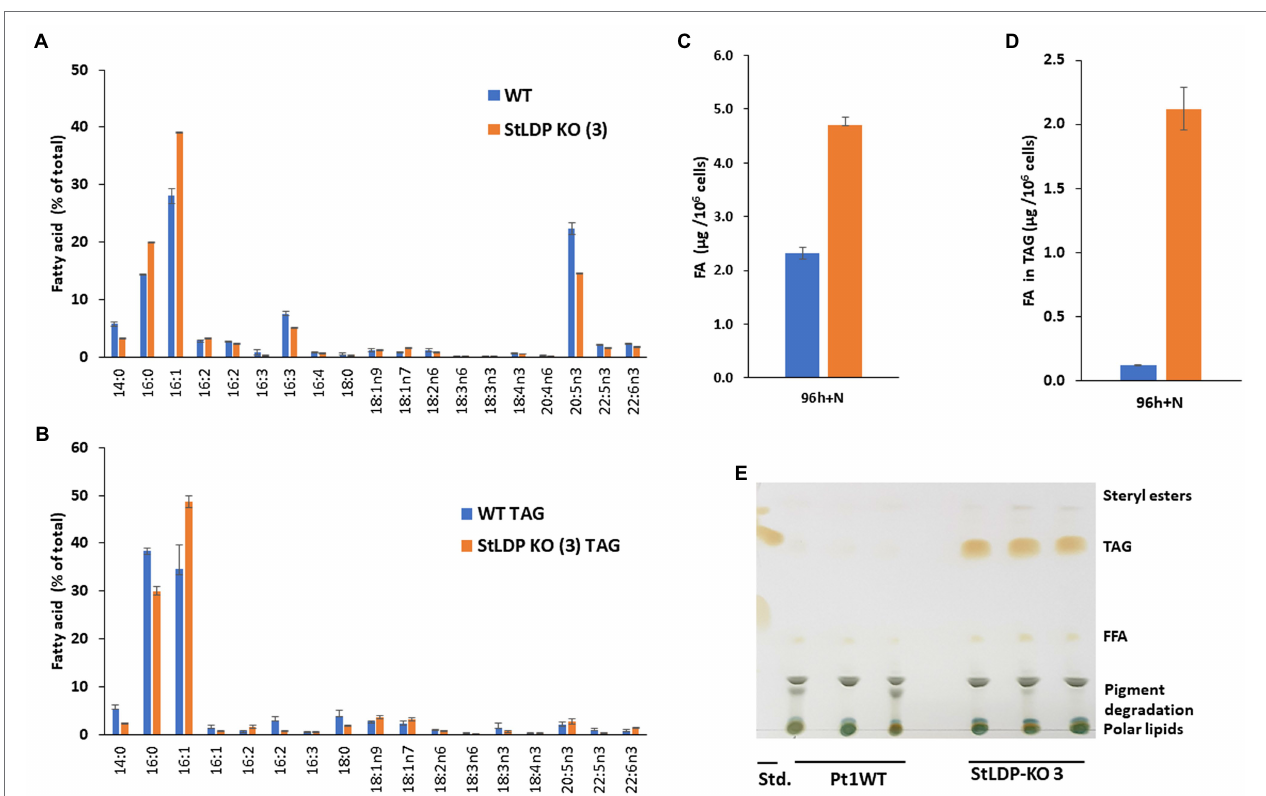
FIGURE 5 | Fatty acid analysis of wild-type Pt1 and StLDP -KO (3) under nutrient-replete conditions by gas chromatography (GC). (A) Relative abundance of total fatty acids (%) after 96 h of cultivation in a nutrient-replete medium. (B) Total fatty acid content per 10 6 cells. (C) Relative abundance of fatty acids in TAG (%). (D) Fatty acid content in TAG per 10 6 cells. (E) Separation of neutral lipids by TLC in a solvent system used for TAG